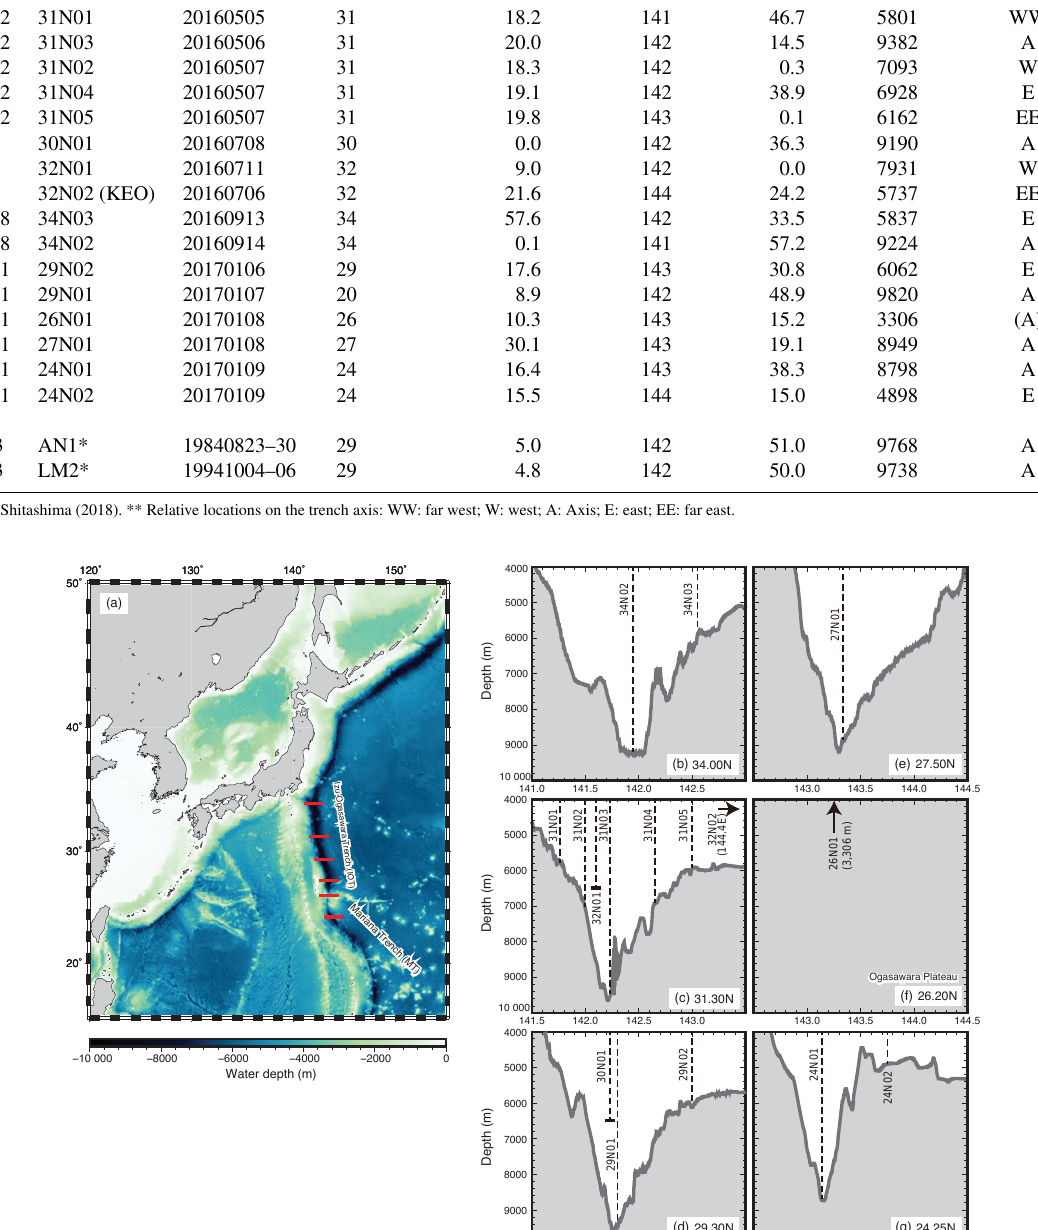
(SBE3plus) was calibrated in situ with a deep ocean standard thermometer (SBE35; 7000 m rated) to correct a pressure de- pendency of the CTD thermometer (Uchida et al., 2015). The full dataset of the CTD observations will be deposited on